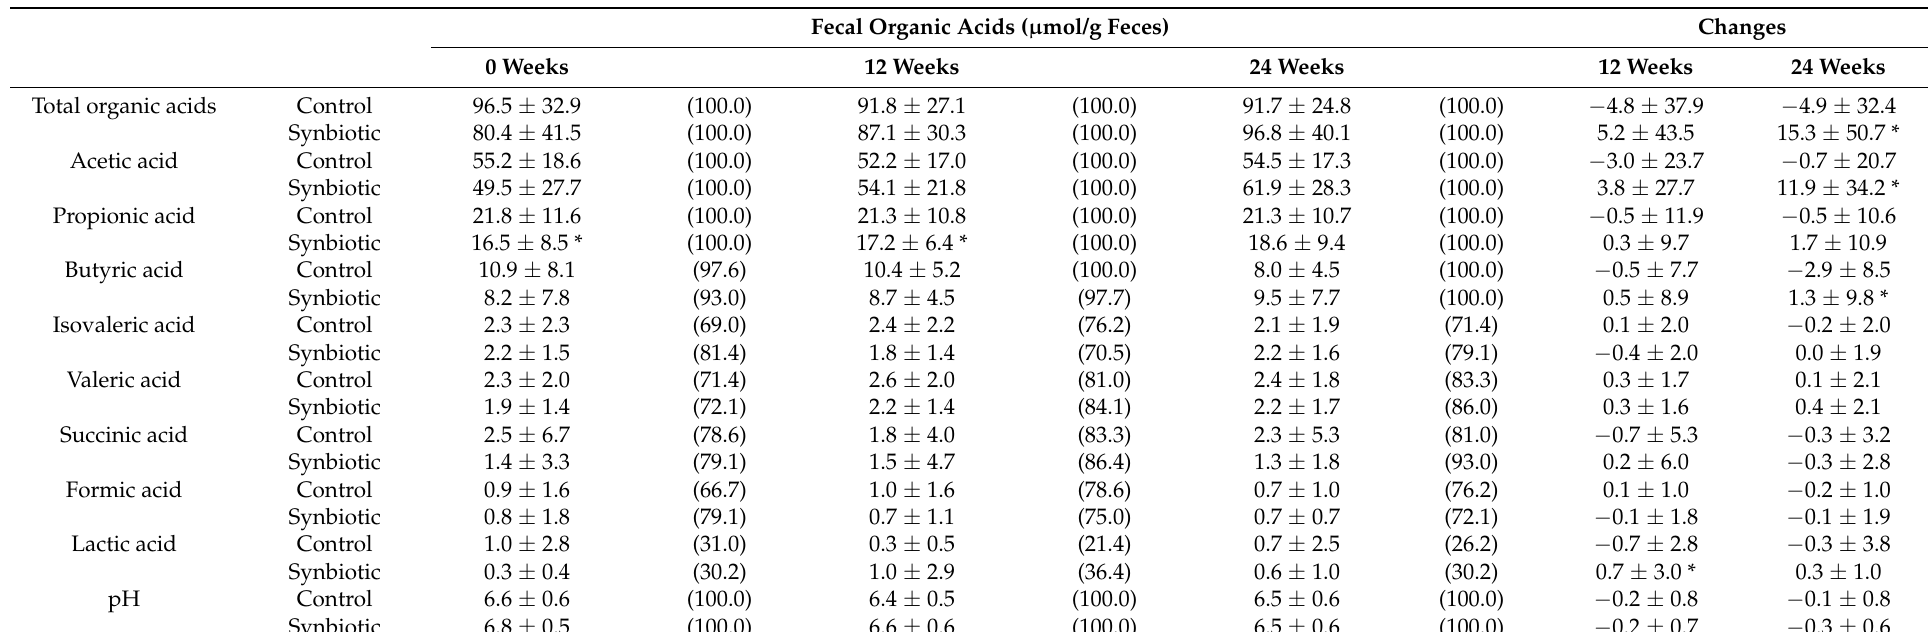
Table 7. Serial changes in fecal organic acids and